Question: What form of chart is displayed?
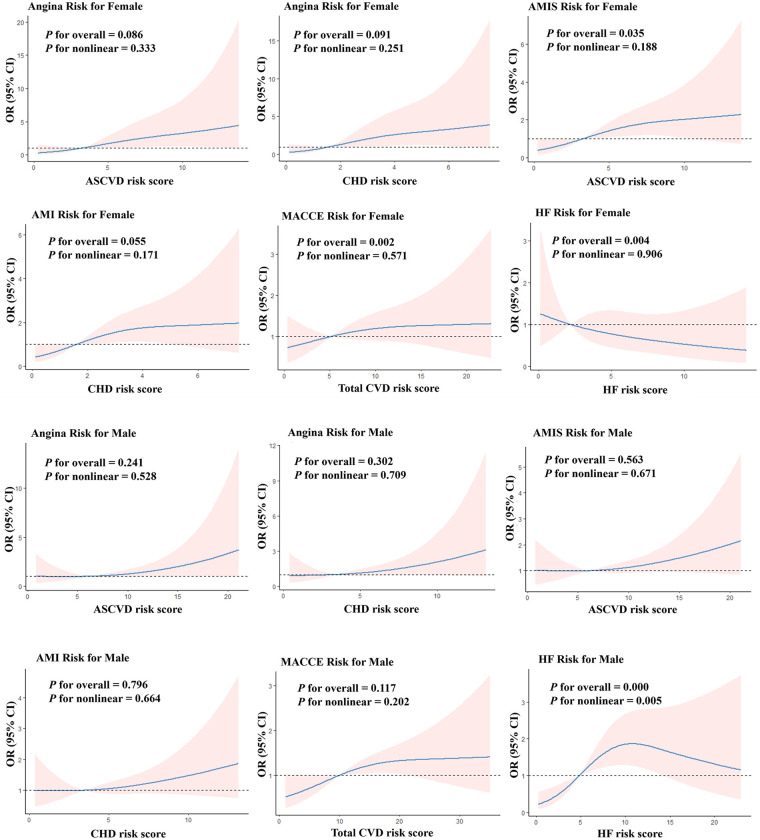
Answer: line